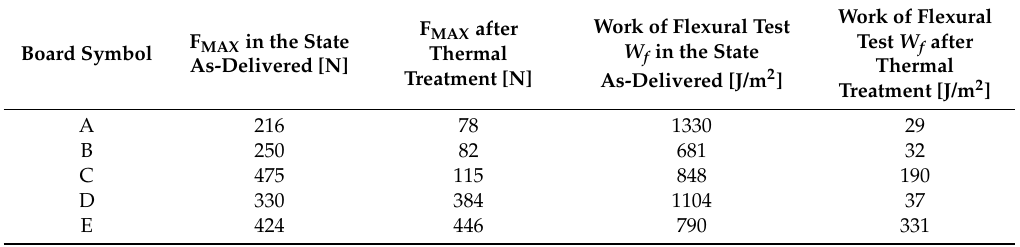
Table 2. The results of the mechanical tests performed on the investigated FCB compositions.